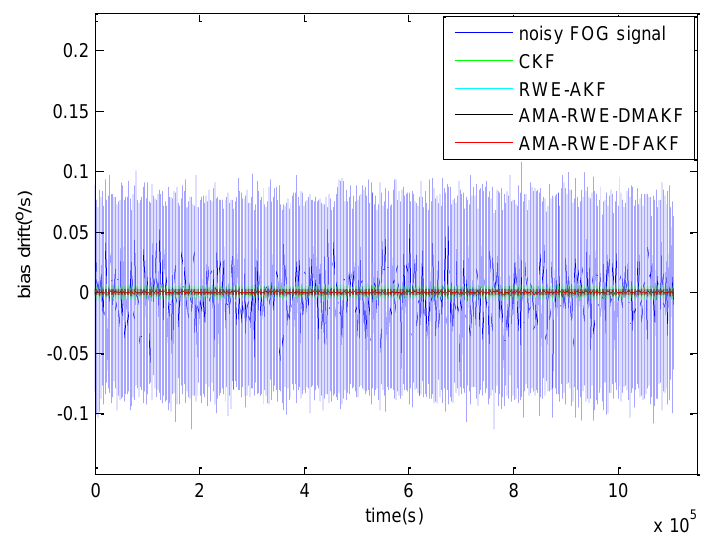
Figure 4. Denoising results of FOG signal in static